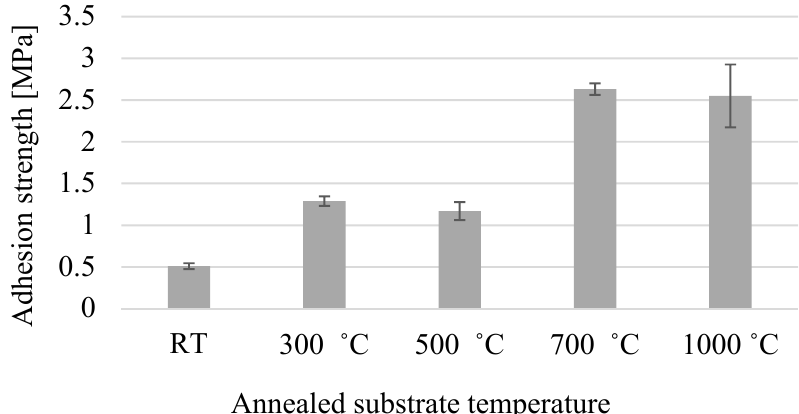
Figure 2. Adhesion strength of the TiO 2 coating on annealed SUS 304.